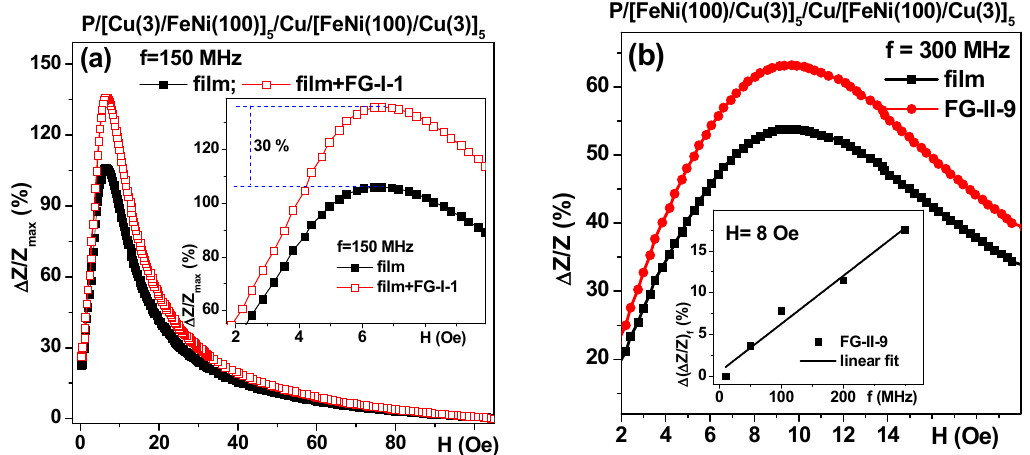
Figure 12. Field dependence of the Δ Z / Z ratio for thin film FeNi/Cu-based MI sensitive element measured either without gel/ferrogel or in the presence of gel ( a ) f = 150 MHz; ( b ) f = 300 MHz. Dashed lines (Inset ( a )) show the difference between the MI element itself and the MI element covered by FG-I-1. P-polymer flexible substrate, numbers in the description of the multilayered structure are layer thicknesses. Inset ( b ) shows the difference in the field of 8 Oe between Δ Z / Z value for FG-II-9. All units for the layer thicknesses are nanometers.